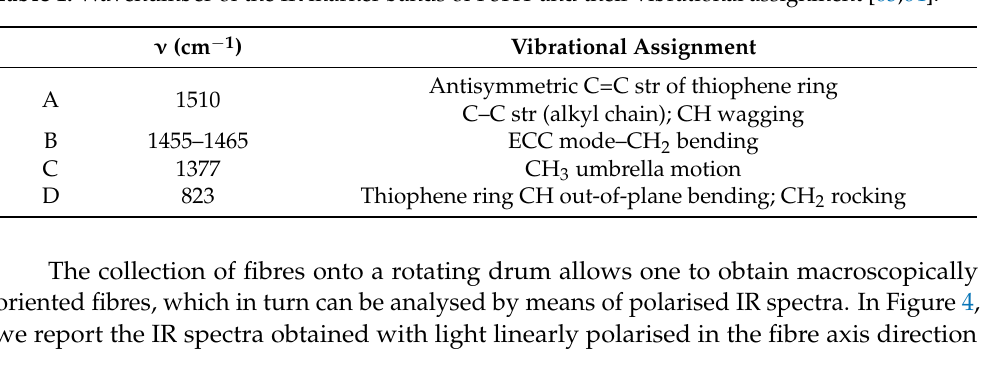
Table 1. Wavenumber of the IR marker bands of P3HT and their vibrational assignment